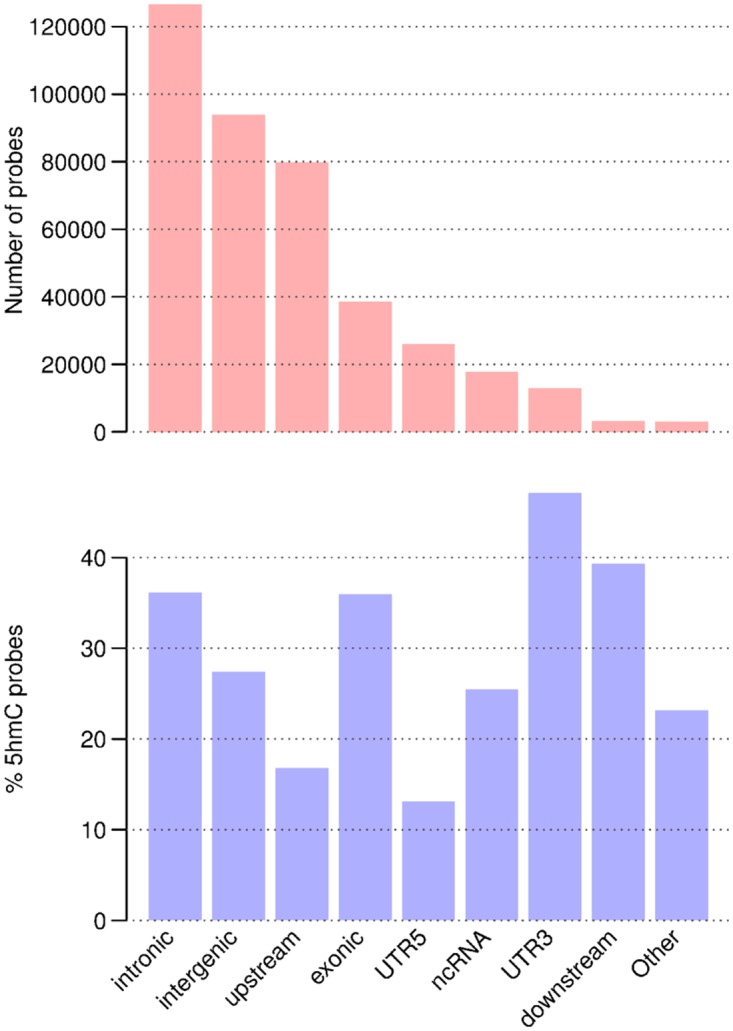
Top: the number of probes in each genomic region in the entire 450K array.The highest number of probes are in introns, followed by intergenic regions. Bottom: the proportion of probes in each region found to have a positive 5hmC signal. While only a small number of probes are designed in 3’UTR’s (12984), this region has the highest proportion of probes with a positive 5hmC signal (47%). Regions labeled “Other” are those that do not fit into any of the previous categories.